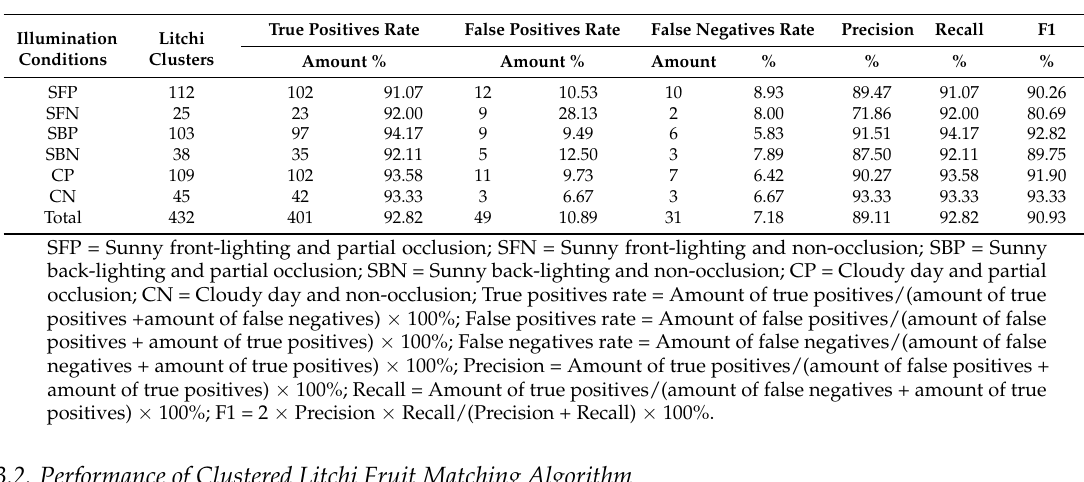
Table 1. The recognition results of the proposed method.